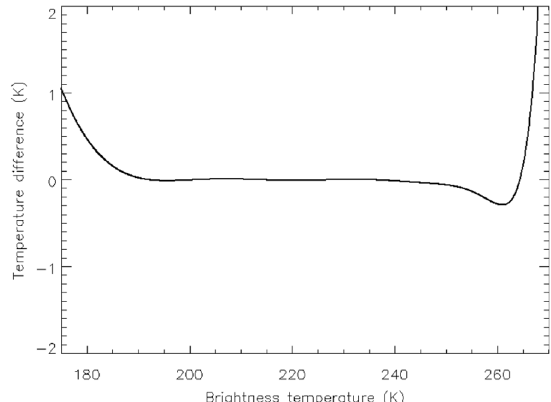
Fig. 8 Difference of brightness temperatures derived from the precise theoretical function and the approximated